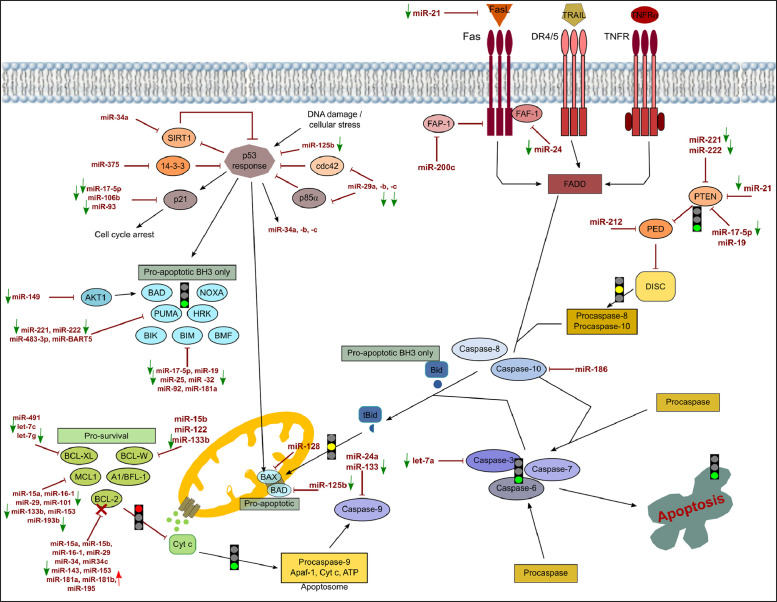
The core apoptotic pathway and its regulation by miRNAs in THP-1 cells exposed to 5 µg ml−1 Cd, as 11.4 µg ml−1 Cd(II). The figure depicts events in the intrinsic and extrinsic apoptotic pathways. In the whole pathway, point and block arrows indicate activation or inhibition, respectively. In the experimental conditions, the arrows next to the miRNAs indicate an increase or decrease of the miRNA. A red arrow indicates an increase in a specific miRNA and its target repressed is indicated with a red cross. A green arrow indicates a decrease with lack of repression of its specific target. As a result, the specific step is locked (red light) or unlocked (green light) or could be unlocked (yellow light).Note: DIANA-Tarbase database and DIANA-mirPath were used to obtain the data to create this chart.